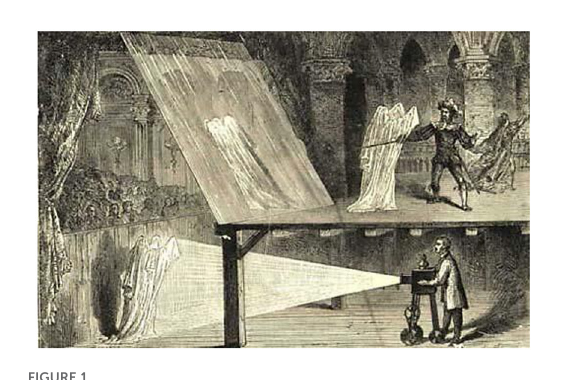
FIGURE1 Early image of the phantasmagoria. https://webarchive.nla.gov. au/awa/20040204192315/http://www.acmi.net.au/AIC/